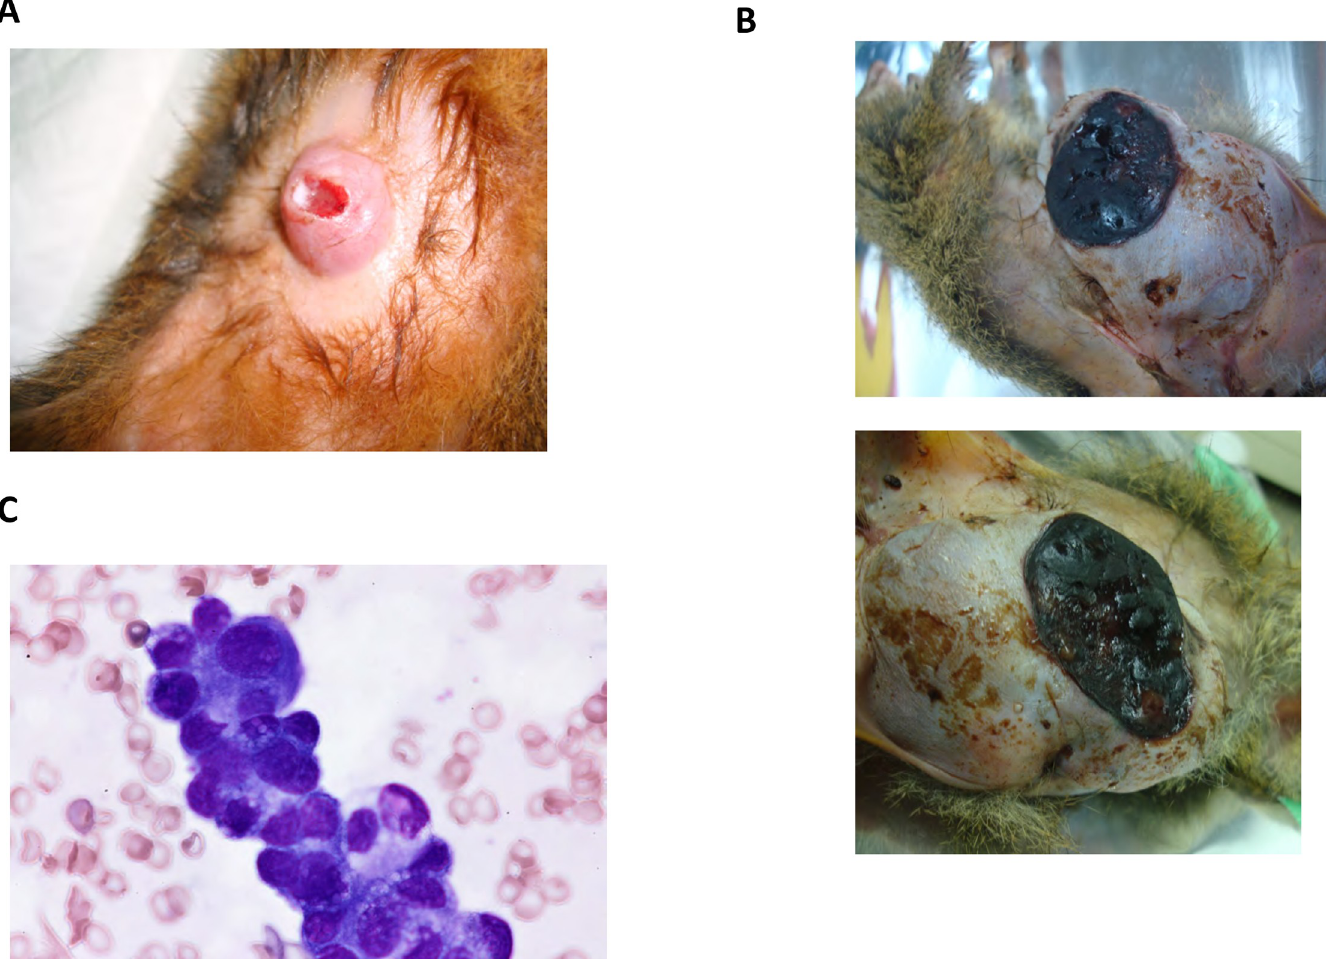
Fig 3. ( A ) Outlook of tree shrew spontaneous mammary tumor (No.75 intraductal papillary adenomas, 4 yeas 3 months old), ( B ) tubulopapillary carcinoma (No.75, 6 year 1 month old), and ( C ) cytodiagnosis of tree shrew No.26 mammary gland tumor (3 year 10monts old). Tumor cells are showing features of malignant epithelial